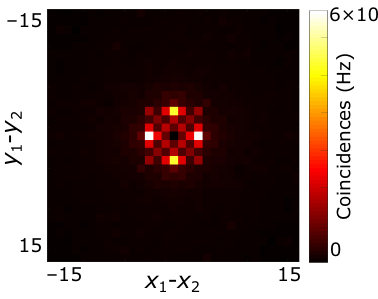
FIG. 5. The crosstalk intensity pattern. The JPD minus- coordinate projection measured with no light falling on the sensor. A total of 7 × 10 8 frames are